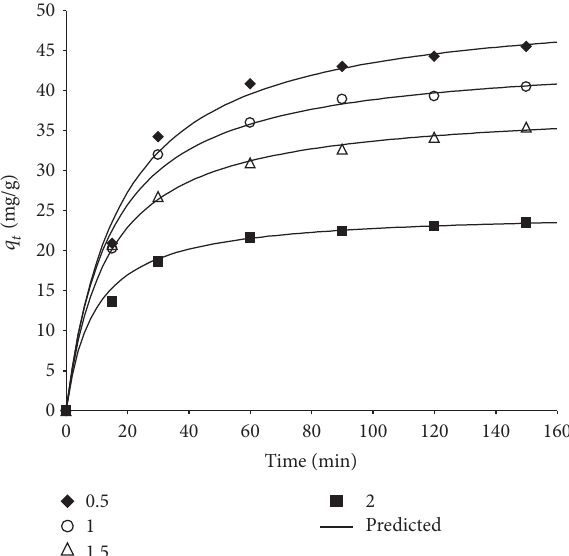
F 3: Effect of adsorbent dosage (agitation speed = 200RPM,